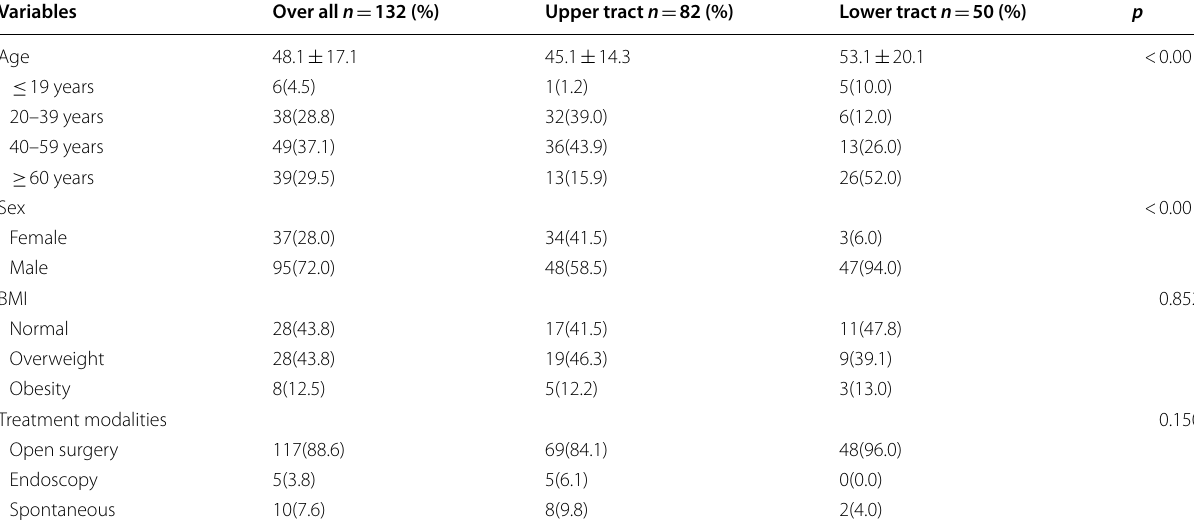
Table 2 General characteristics of the study population by sites of stones